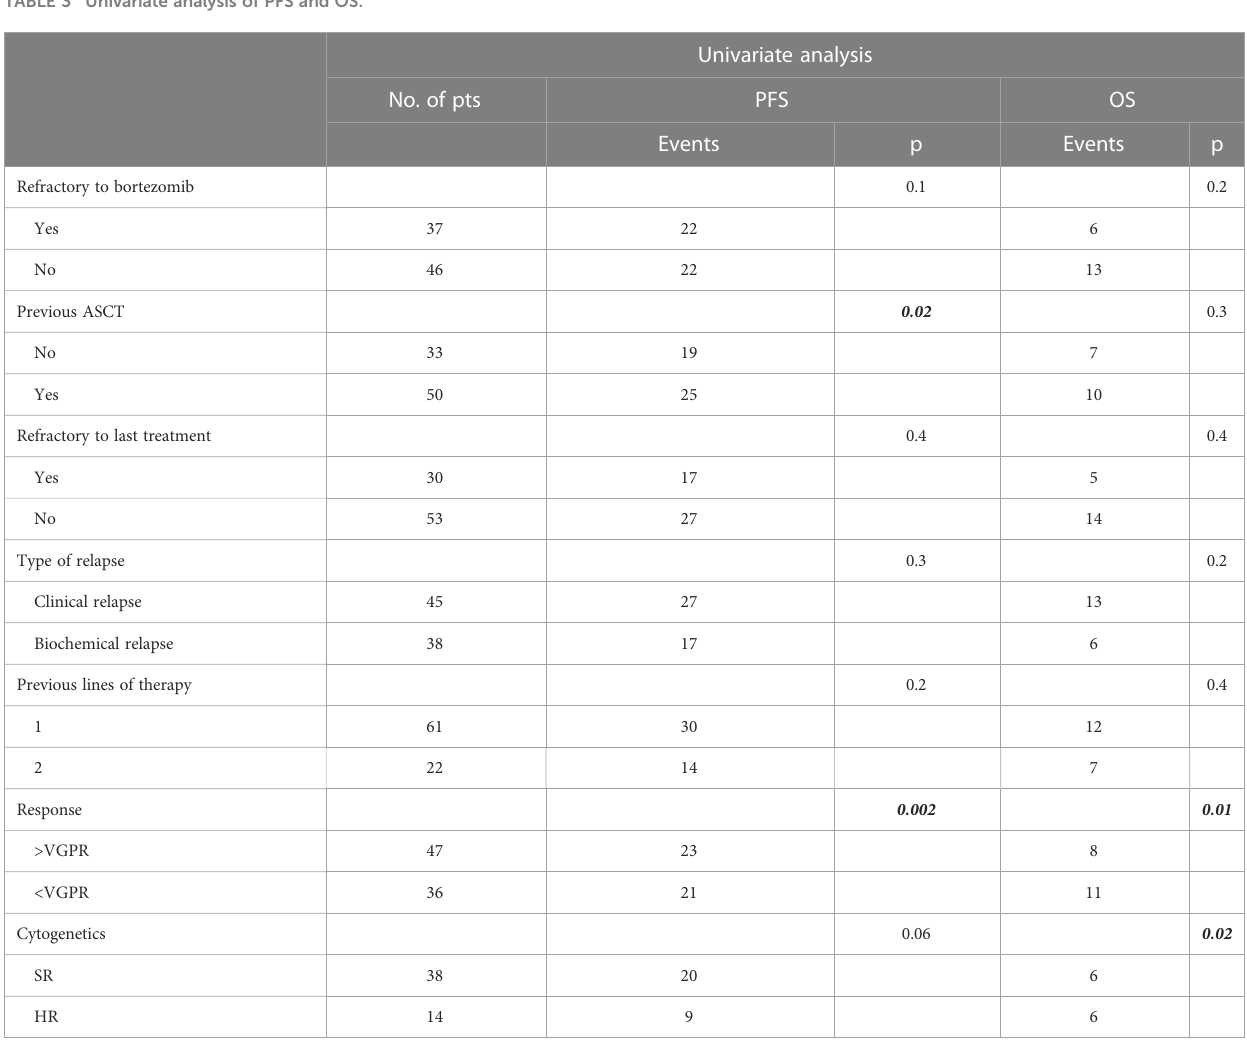
TABLE 3 Univariate analysis of PFS and